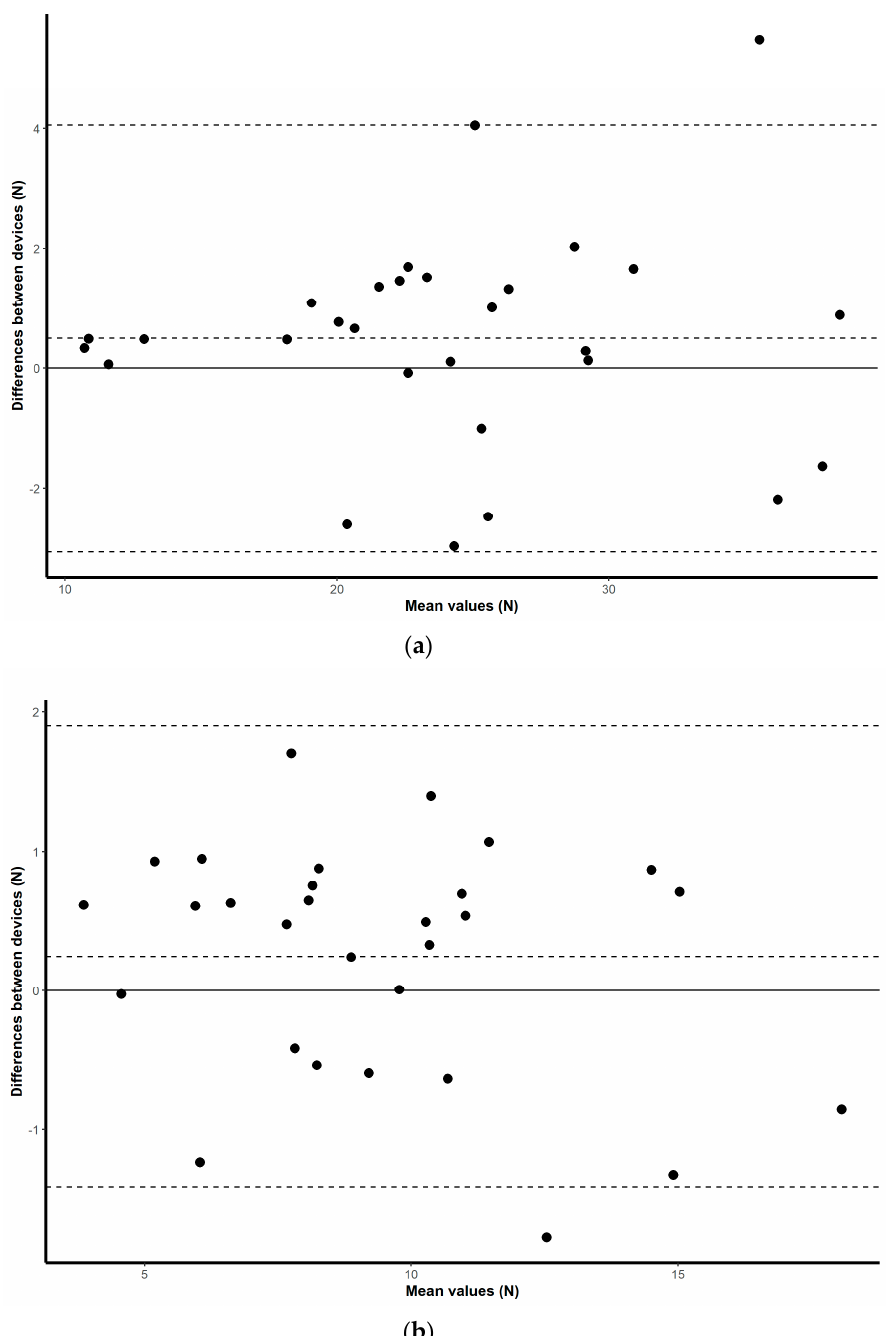
Figure 6. Session one mean difference plot comparison of the results from the HX711 microcontroller- based load cell and the handheld dynamometer for: ( a ) maximal isometric leg extension; ( b ) maximal isometric bicep flexion. The middle-dashed line represents the mean difference and the upper and lower dashed lines represent the 95% limits of agreement (mean ± 1.96 * SD).